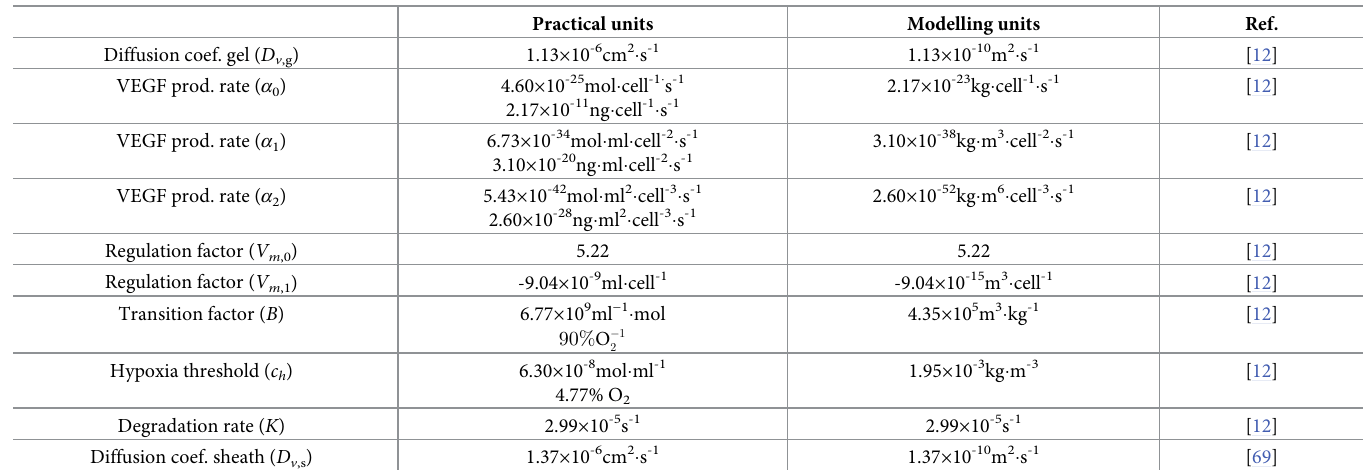
Table 5. VEGF transport parameters.